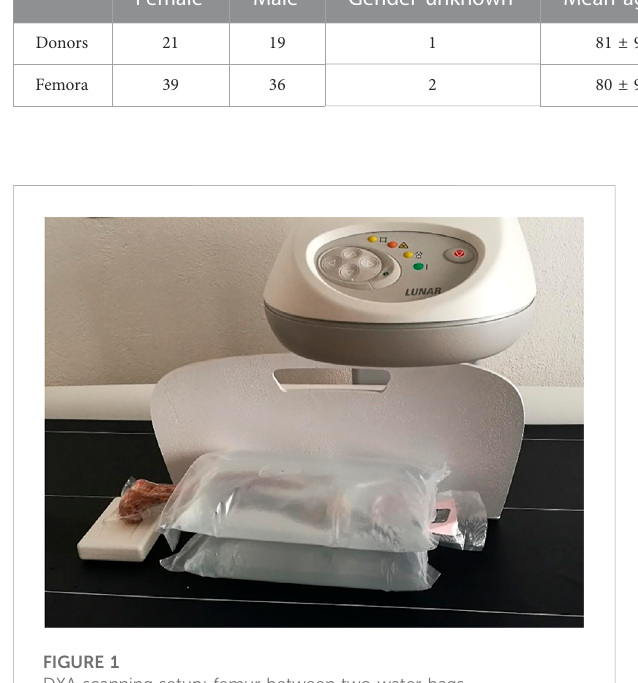
FIGURE 1 DXA scanning setup: femur between two water